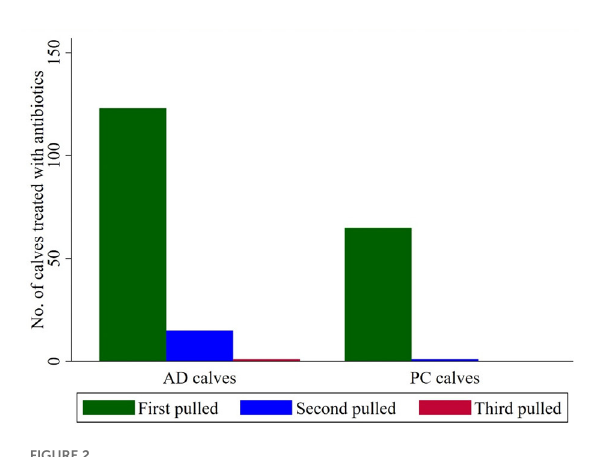
FIGURE2 Number of calves treated with antibiotics over D40 at the feedlot. First pulled-calves those were sick for the first time, pulled and treated with an antibiotic. Second pulled-calves whose disease signs persisted for > 72h after the first antibiotic treatment. Third pulled-calves whose disease signs persisted for > 72h after the second antibiotic treatment.